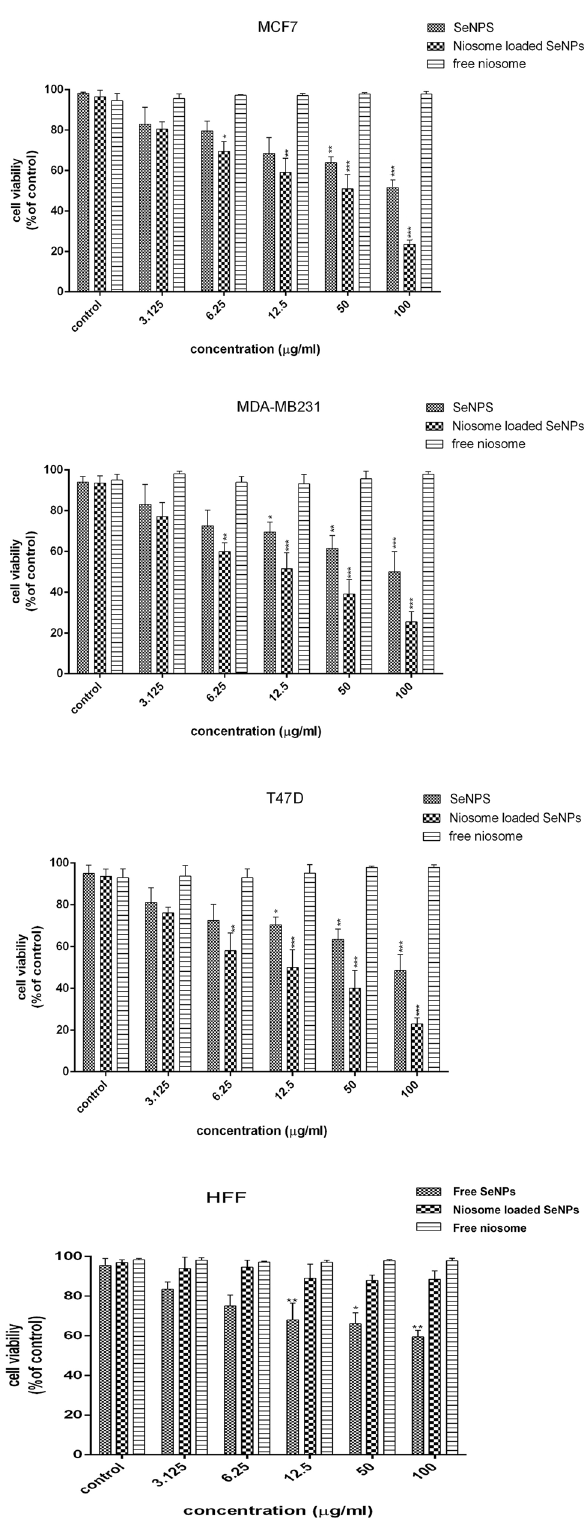
Figure 7. In vitro cytotoxicity of free SeNPs, niosome loaded SeNPs, and free niosome on MCF-7, T47D MDAMB231, and normal HFF cell. n = 3, *** p < 0.0001; ** p < 0.01; * p <